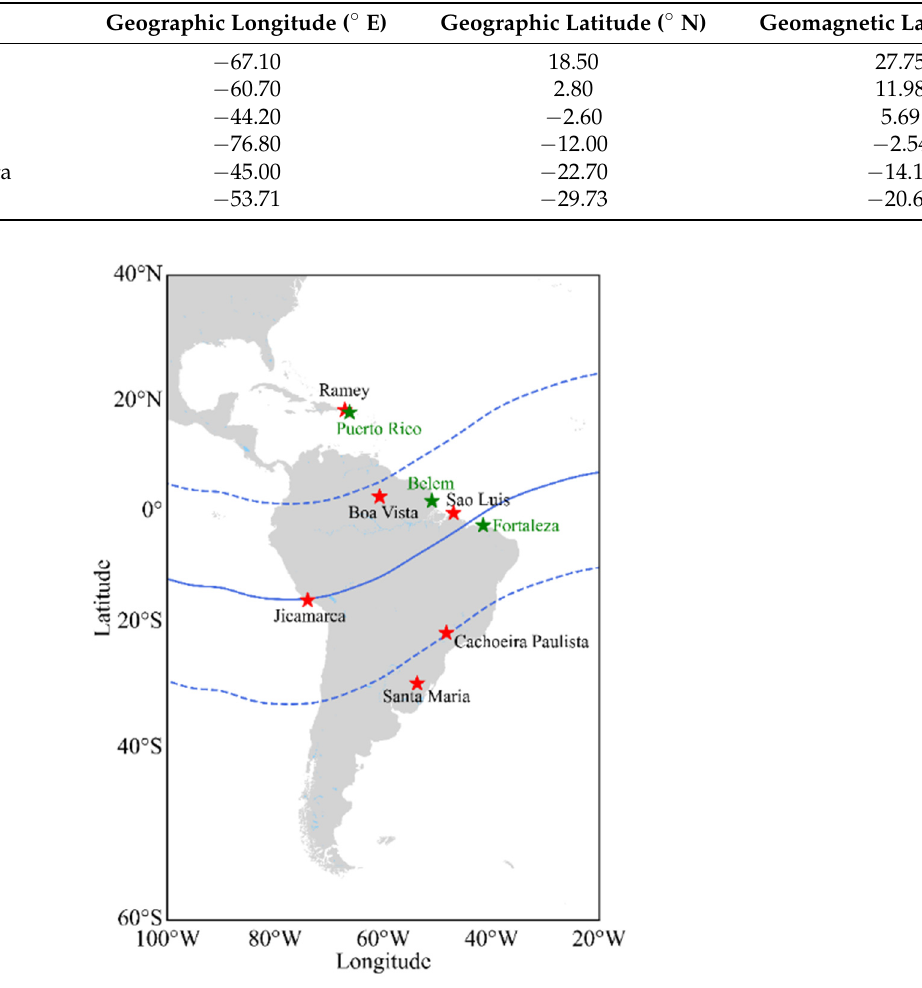
Table 1. Geographic and geomagnetic locations of the six ionosonde stations used.